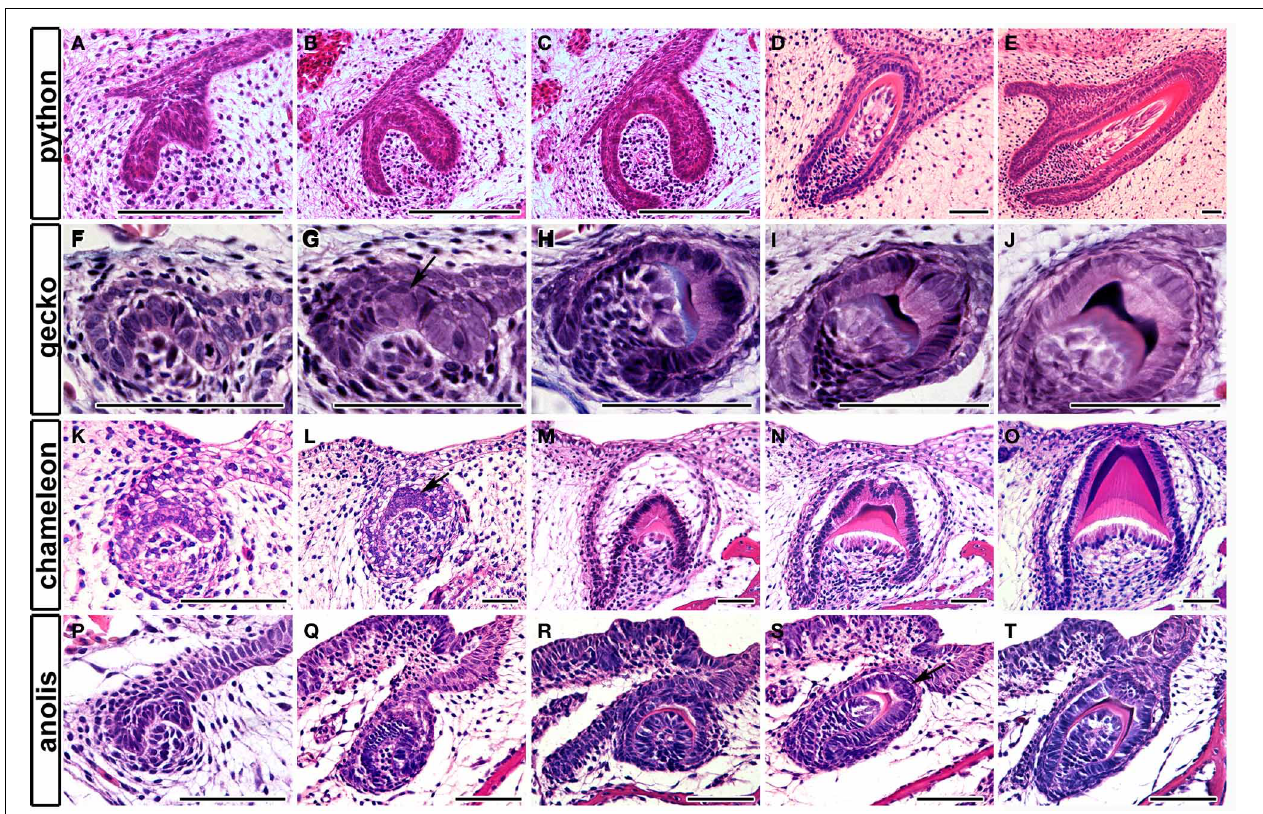
FIGURE 3 | Tooth crest formation and the epithelial bulge. Frontal sections through reptilian teeth as they develop from cap to bell stage and final differentiation. (A–E) Unicuspid snake, Python molurus . No bulge is found in the inner enamel epithelium. (F–J) Bicuspid gecko Paroedura picta . A bulge is found in the central part of the inner enamel